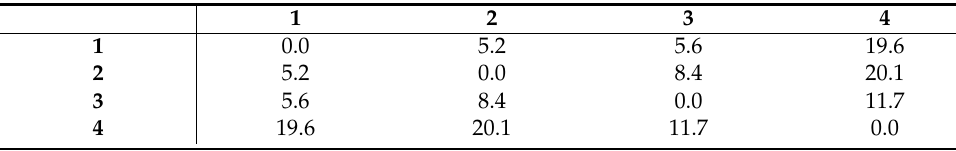
Table 5. Effort matrix E 4 for route four.